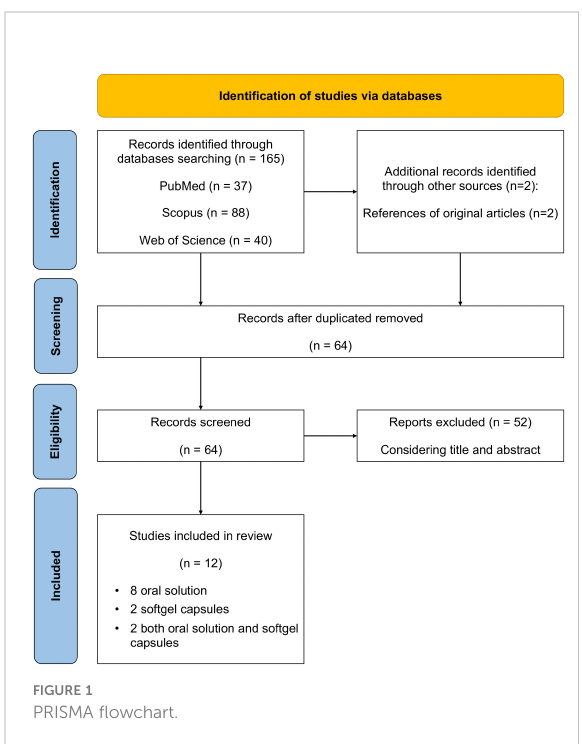
FIGURE 1 PRISMA fl